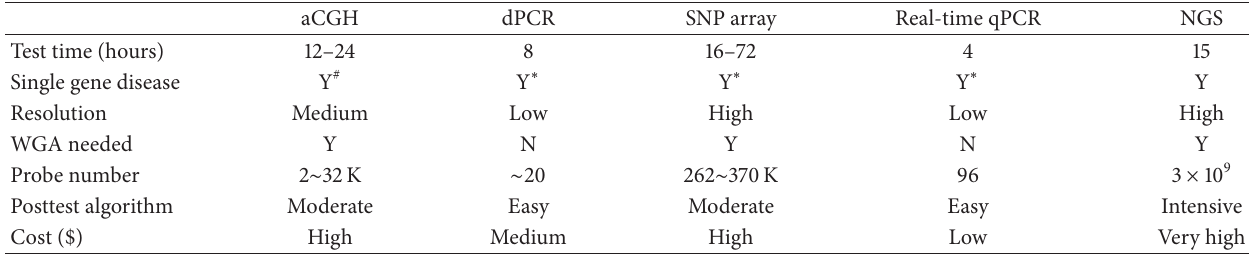
Table 1: Comparison of available CCS for 24